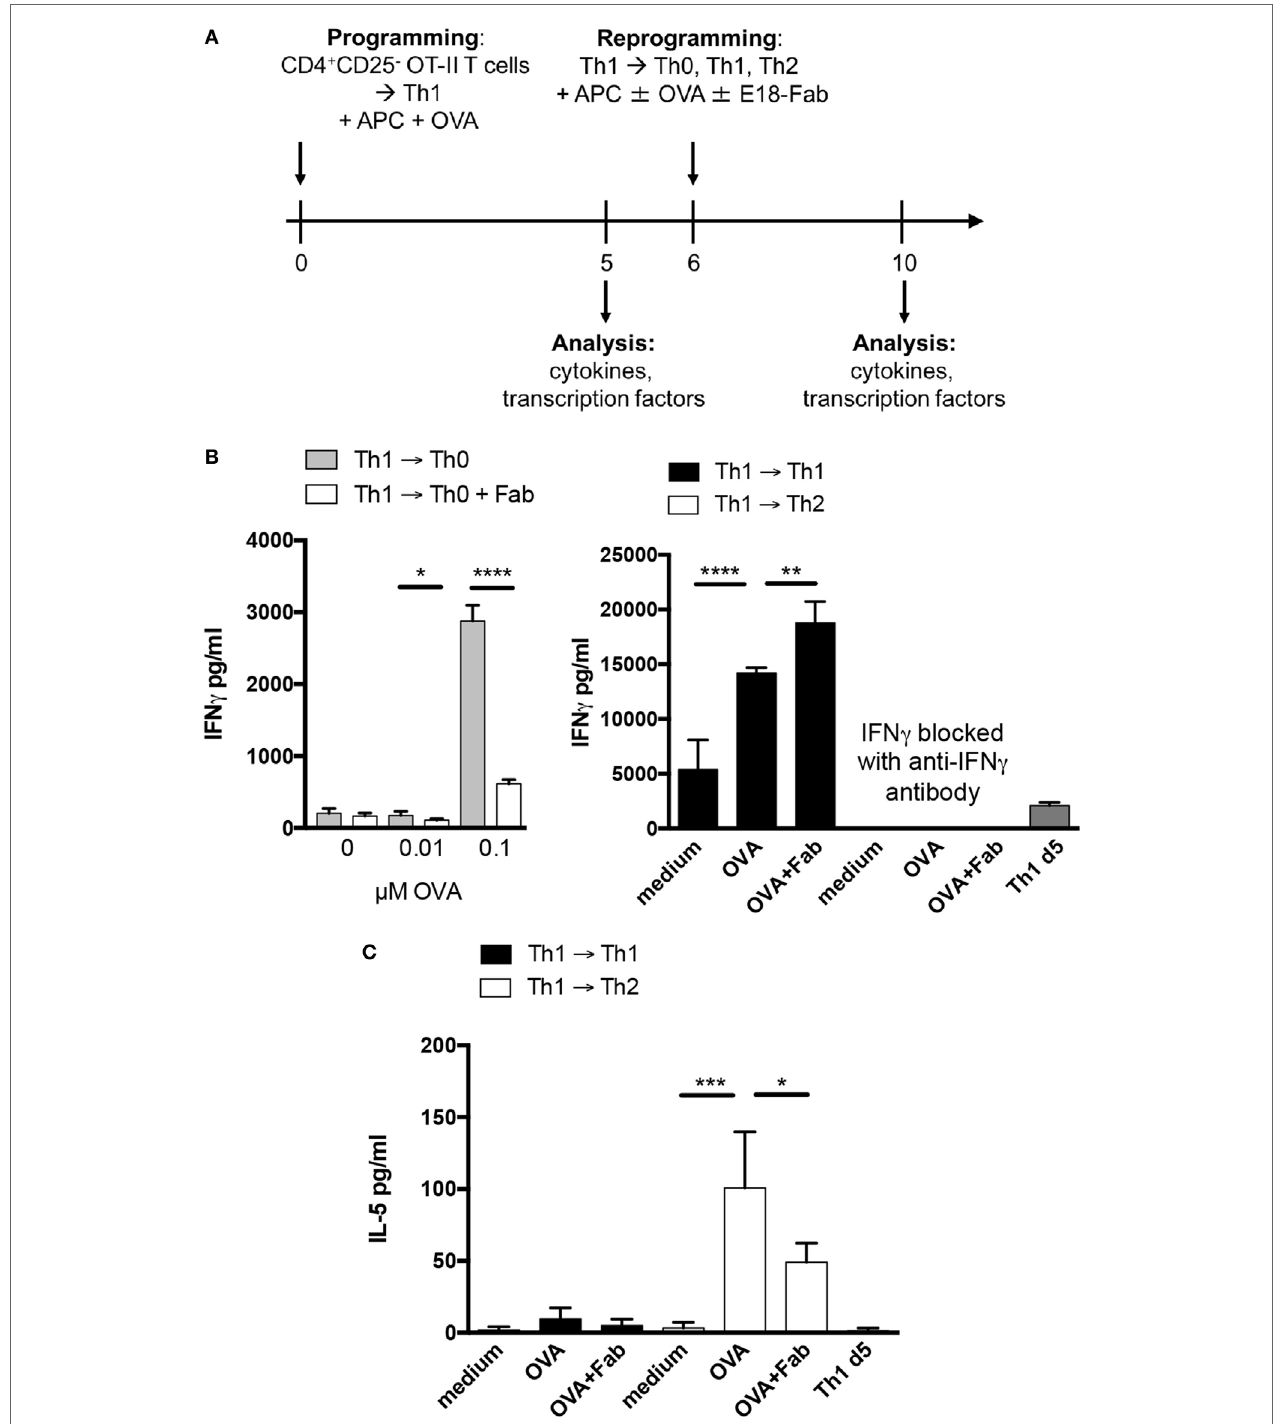
FigUre 3 | CD28 costimulation increases cytokine release from T helper 1 cells in vitro . (a) Isolated CD4 + CD25 − T cells of OT-II Thy1.1 + / + mice were co-cultured with T cell-depleted splenocytes under Th1 conditions for 6 days and afterward reactivated under Th2, Th0, or Th1 conditions for additional 4 days in the presence and absence of OVA peptide and E18-Fab fragment. (B) Interferon γ concentrations in supernatants 4 days after restimulation under Th0 (left graph), Th1, or Th2 conditions (both right graph) in the presence or absence of E18-Fab and up to 0.1 µM (left) or 1 µM ovalbumin (OVA) peptide (right). (c) IL-5 concentrations in supernatants 4 days after restimulation with 1 µM OVA peptide under Th1 or Th2 conditions and in the presence or absence of E18-Fab. Graphs show mean + SD of triplicate cultures from one experiment. The results are representative of two to five independent experiments and were tested with a two-tailed unpaired t -test (* p < 0.05, ** p < 0.005, *** p < 0.001, **** p <